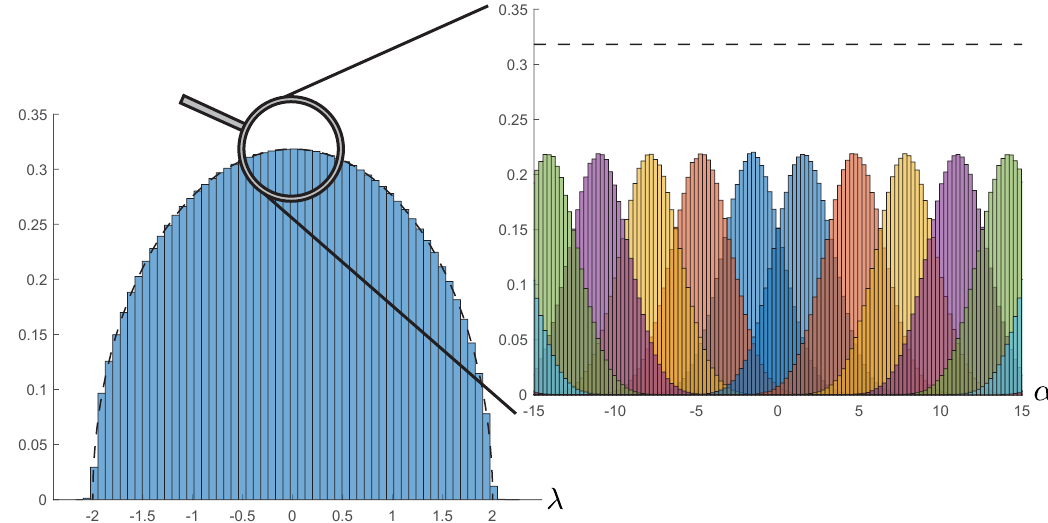
Figure 1. In the left diagram observe the histogram corresponding to the eigenvalues of 10 6 Hermitian random matrices of size N = 100 , drawn from the Gaussian ensemble. The dashed line corresponds to Wigner’s semi circle law (1.6). To the right, we zoom-in the λ ∼ 0 region by taking the double scaling limit α i = λ i ~ N (3.10) with ~ = 1 . The histograms in this second plot correspond to the ordered eigenvalues of each sample